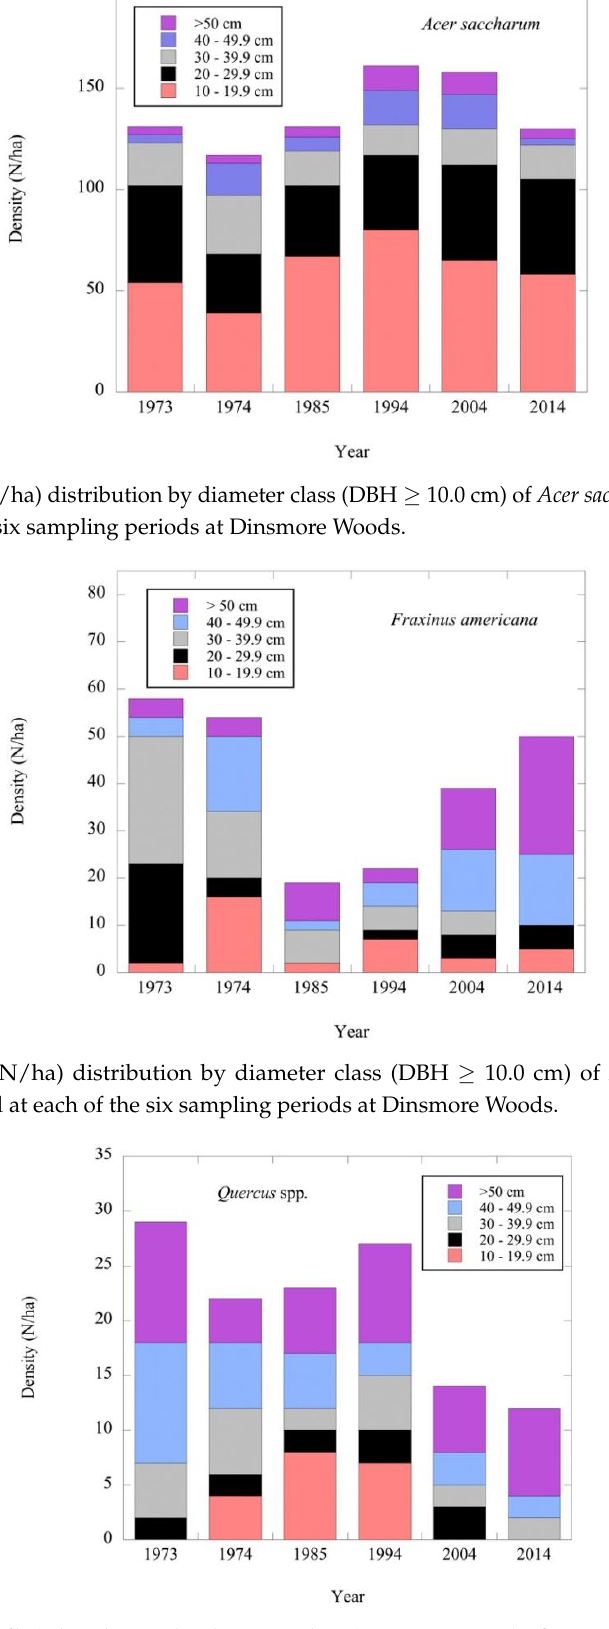
Figure 5. Density (N/ha) distribution by diameter class (DBH ≥ 10.0 cm) of Quercus spp. individuals recorded at each of the six sampling periods at Dinsmore Woods.